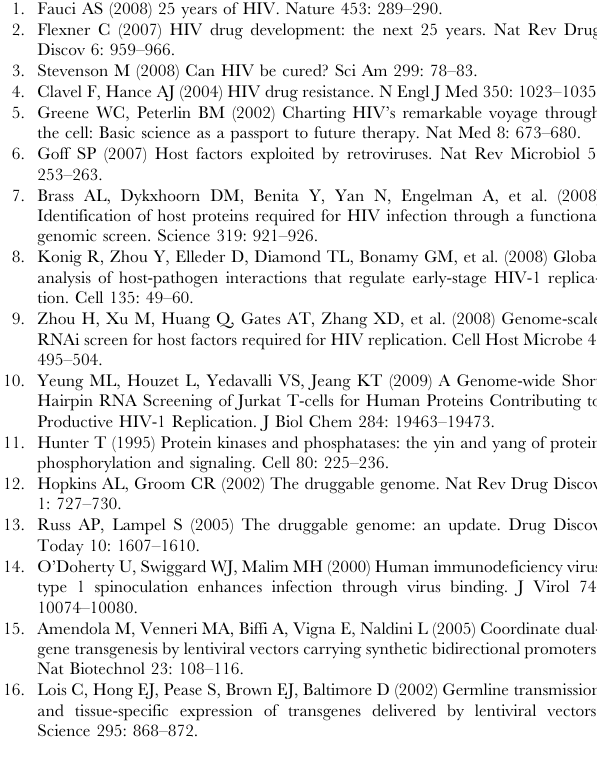
Table S2 Oligonucleotide sequence for target-gene cDNA amplification by qPCR.